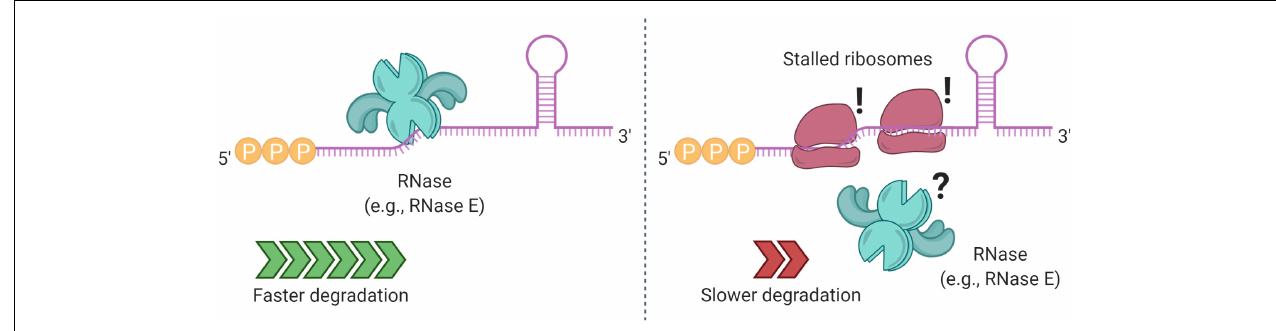
FIGURE 5 | Ribosome binding and stalling can alter mRNA degradation. In some cases, ribosome stalling can mask RNase cleavage sites, increasing the half-life of a transcript. Elements that prevent ribosome binding, such as translation initiation inhibitors, lead to shorter mRNA half-lives.